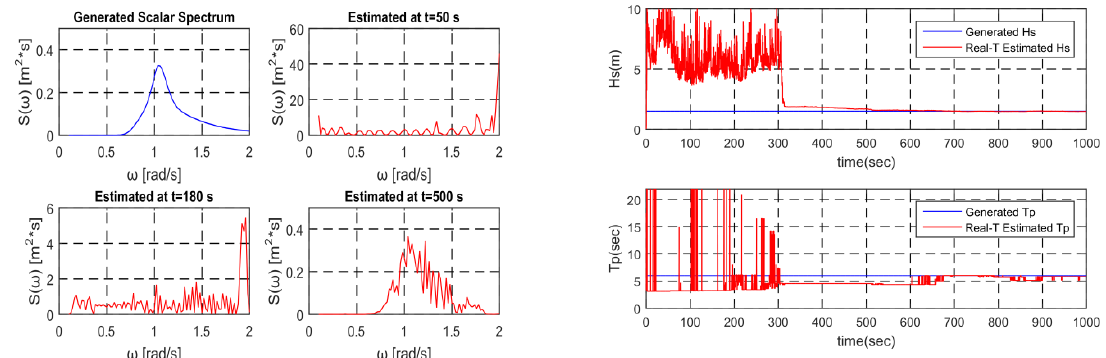
Figure 30. Generated and estimated spectrum/Evolution of parameters (Sea sate 1, Hs = 1.5 m, Tp = 6 s).